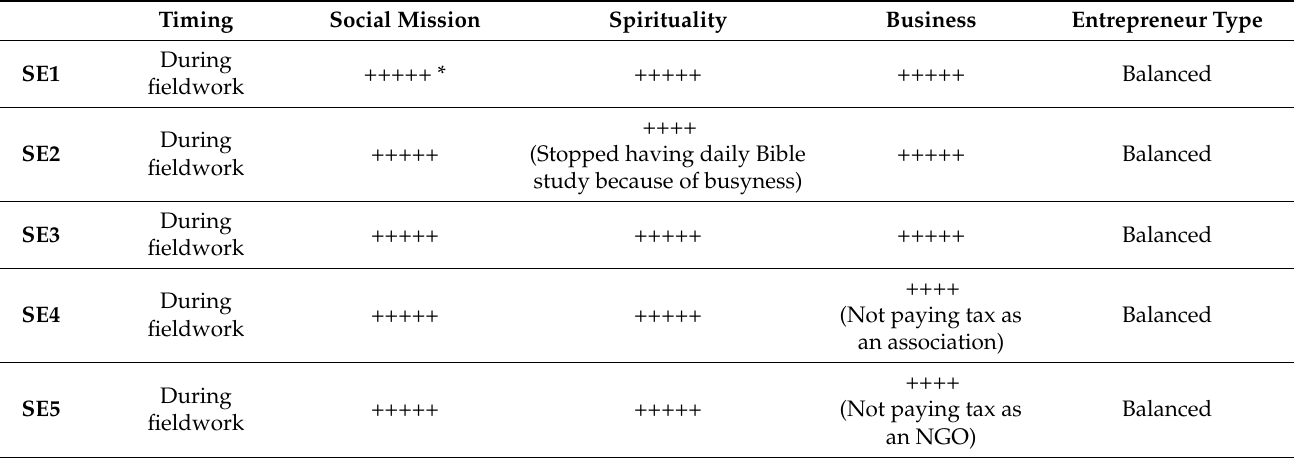
Table 3. Emphasis on institutional logics (balanced